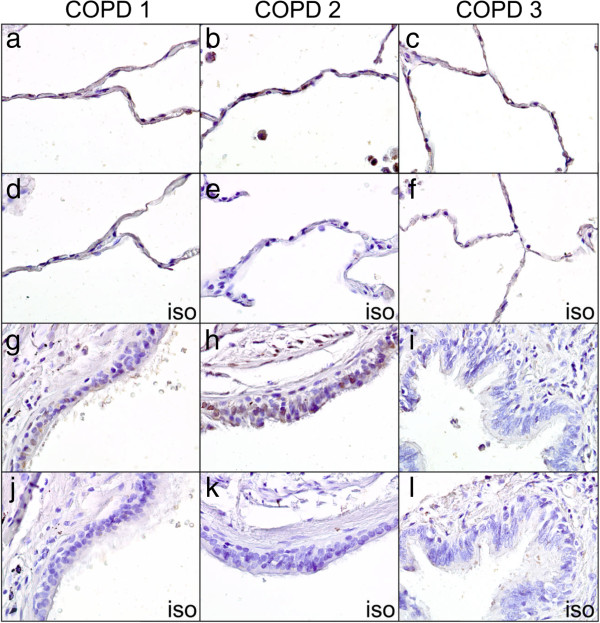
Immunohistochemistry of 5-HT4R in COPD lung tissue. Weak 5-HT4R staining was found in the nuclei and cytoplasm of pneumoctyes in the alveolar regions of all COPD samples (a-c). In the bronchial epithelium COPD1 had weak nuclear staining (g), COPD2 had moderate nuclear and cytoplasmic staining (h) whilst COPD3 was negative for the 5-HT4R protein (i). All isotype controls were negative (d-f and j-l). X40 magnification.